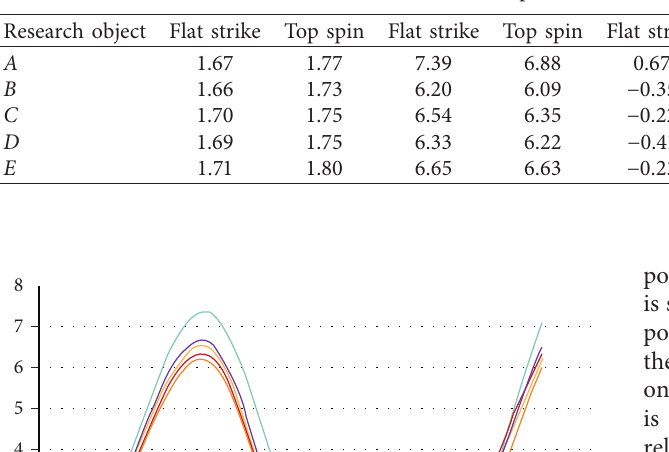
Table 2: Results of the research on the position of throwing shots for the flat strike and the top spin.